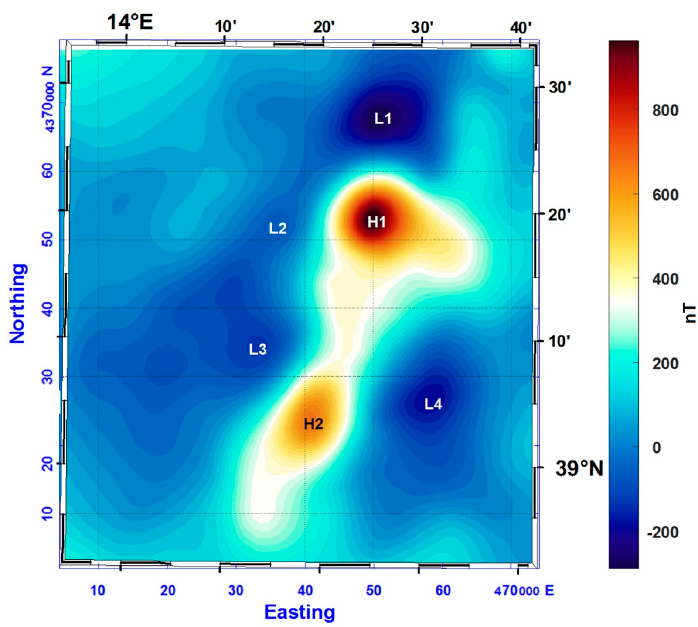
Figure 13. Total field aeromagnetic anomalies in the area of Marsili Seamount at the elevation of 1463 m above sea level. Letters identify magnetic anomalies described in the text. The shipborne magnetic map (Figure 12) shows a number of small details not vis- ible in the aeromagnetic map. It consists of a complex pattern of several highs and lows that cannot easily be coupled in dipolar anomalies because of a coalescence of effects and the presence of reverse magnetization. Most of them seem to be distributed per- pendicular to the main axis of the MS and the alternance of highs and lows (in Figure 12, from the seamount axis towards the northwest: H1, L4, H8, L5, and H9; from the seamount axis towards the southeast: H6, L2, H7, and L3) was interpreted as the result of the spreading evolution of the Marsili Basin [29]. Along the central axis there is a presence of other small anomalies as H2 and H3 highs in (Figure 12) or L3 and L6 magnetic lows flanking the seamount from both sides (Figure 12). The downward continuation of the aeromagnetic anomalies to sea level (Figure 14) produces a noticeable increase in information. The aeromagnetic field presents many similarities to the pattern of anomalies recognized in the shipborne data (e.g., L1, H4, H5 and H10). In particular, the two small peaks placed in the central part of the Sea- mount in shipborne magnetic anomalies are also detectable in the airborne data con- tinued to sea level (H3 an H2 in Figure 14). The same applies for most of the low-amplitude highs and lows already shown in the shipborne data map along the western and the eastern side of the seamount (in Figure 14, from the seamount axis towards the northwest: H1, L4-L5 and H8-H9, and H8; from the seamount axis towards the southeast: H6 and L2 and L3). As in the shipborne data, are also visible magnetic lows L3 and L6 flanking the seamount from both sides (Figure 14). However, in the magnetic field continued downward to sea level, it is still not possible to see some fea- tures visible in the map from shipborne survey, such as the central low (L1 in Figure 12)